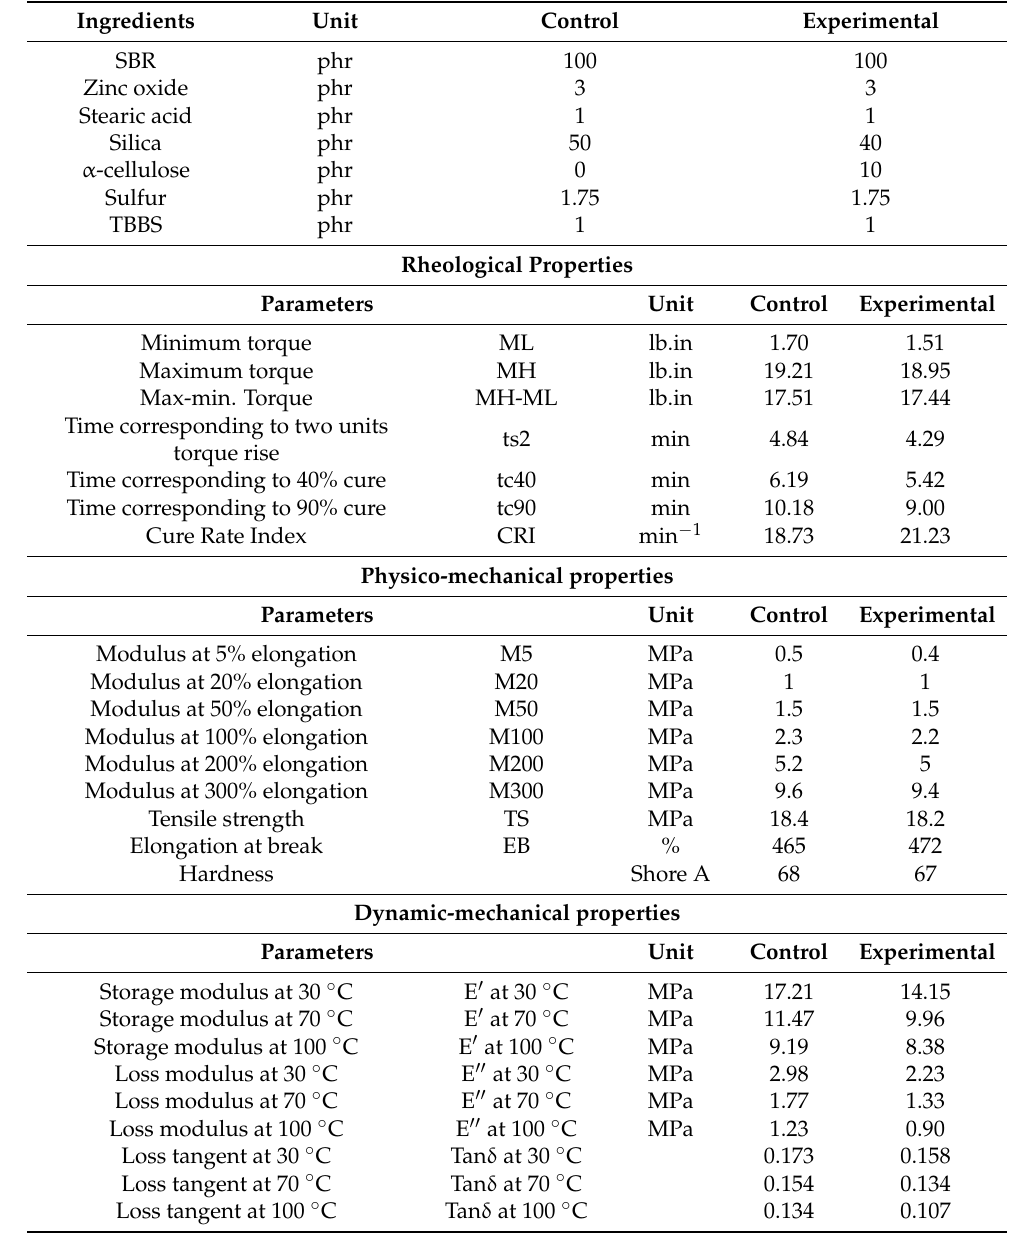
Table 6. Formulation, rheological, physico-mechanical and dynamic properties of silica- containing